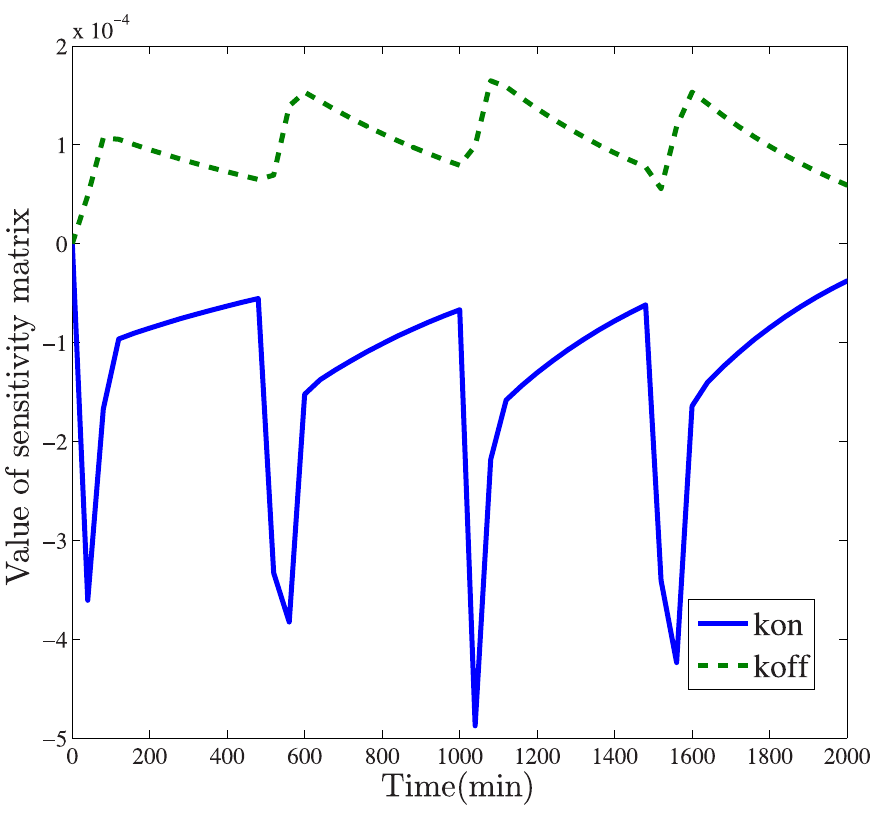
Fig 4. Sensitivity analysis of unbuffered gene circuits. The kinetic parameter k degradation rate k off has positive sensitivity. The values of sensitivity matrices exhibit periodic